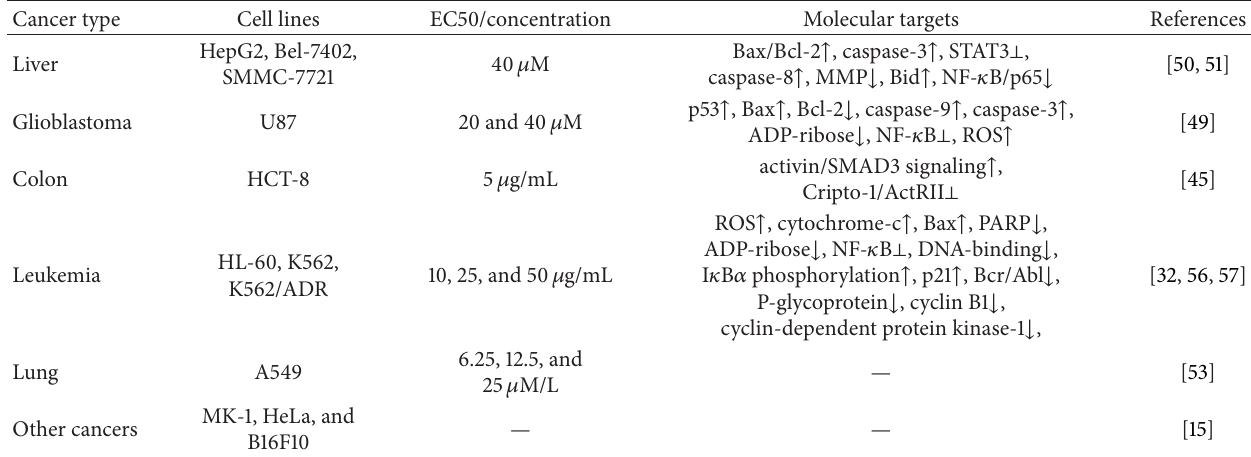
Figure 2: Alantolactone (AL) and isoalantolactone (IAL) target multiple cell signaling pathways. AL and IAL inhibit various targets including transcription factors, enzymes, growth factors and its receptors, kinases, and antiapoptotic proteins. Note: iNOS, inducible nitric oxide synthase; NO, nitric oxide; HO-1, heme oxygenase-1; GST, glutathione-S-transferase; NADP-2; NADH quinone oxidoreductase 1 NAD(P)H dehydrogenase, quinone1; NF- 𝜅 B, nuclear factor kappa B; TNF-R1, TNF receptor-associated factor-1; AP-1, activating protein-1; Bcl-2, B-cell lymphoma protein 2; BAX, Bcl-2-associated X protein; Bid, BH3-interacting domain death; GST, glutathione-Stransferase; GR, glutathione reductase; GGCS, gamma-glutamyl cystein synthetase; PI3K, phosphoinositide 3-kinase; ERK, extracellular receptor kinase; PARP, poly (ADP-ribose) polymerase; IKK, I 𝜅 B- 𝛼 , kinase-alpha; IKK, I 𝜅 B- 𝛽 , kinase-beta; p38MAPK, mitogen-activated protein kinases; and JNK, c- Jun N-terminal kinases. Table 1: Molecular targets of alantolactone in different cancer